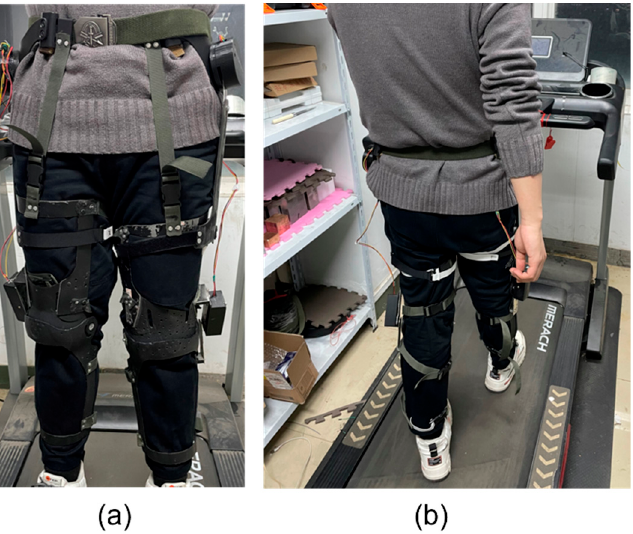
Figure 3. ( a ) The overall wearing effect of the collection device. ( b ) Subject’s gait information collection process.